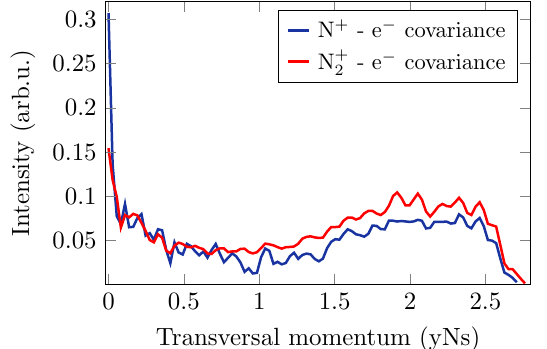
Figure 7. Results of ion-ion covariance analysis. ( a , b ) show covariance maps of the N + ion TOF fragments correlated with the ion VMI detector image, respectively. Furthermore, these maps were treated like raw VMI images and inverted. The results are displayed in the right halves of ( c , d ). For comparison the inverted image of the accumulated ion detector image from Figure 6b is reproduced in the left halves.